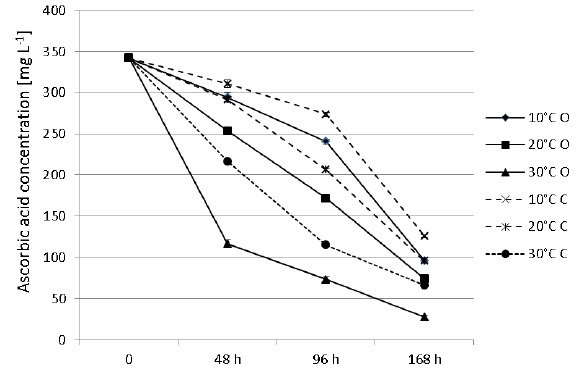
Figure 9: Changes in ascorbic acid concentration during storage of freshly squeezed grapefruit juice in open (O) and closed (C)